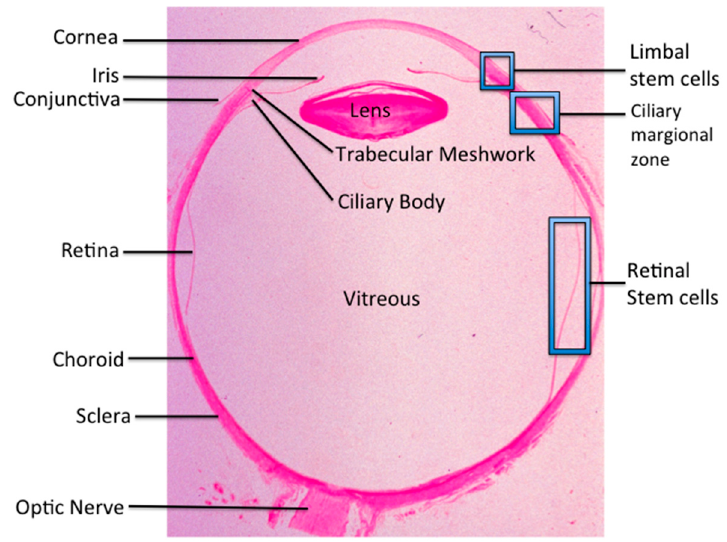
Figure 1. Histology of a normal eye. The square marks indicate ocular stem cell in the eye. (hematoxylin & eosin, ×25).